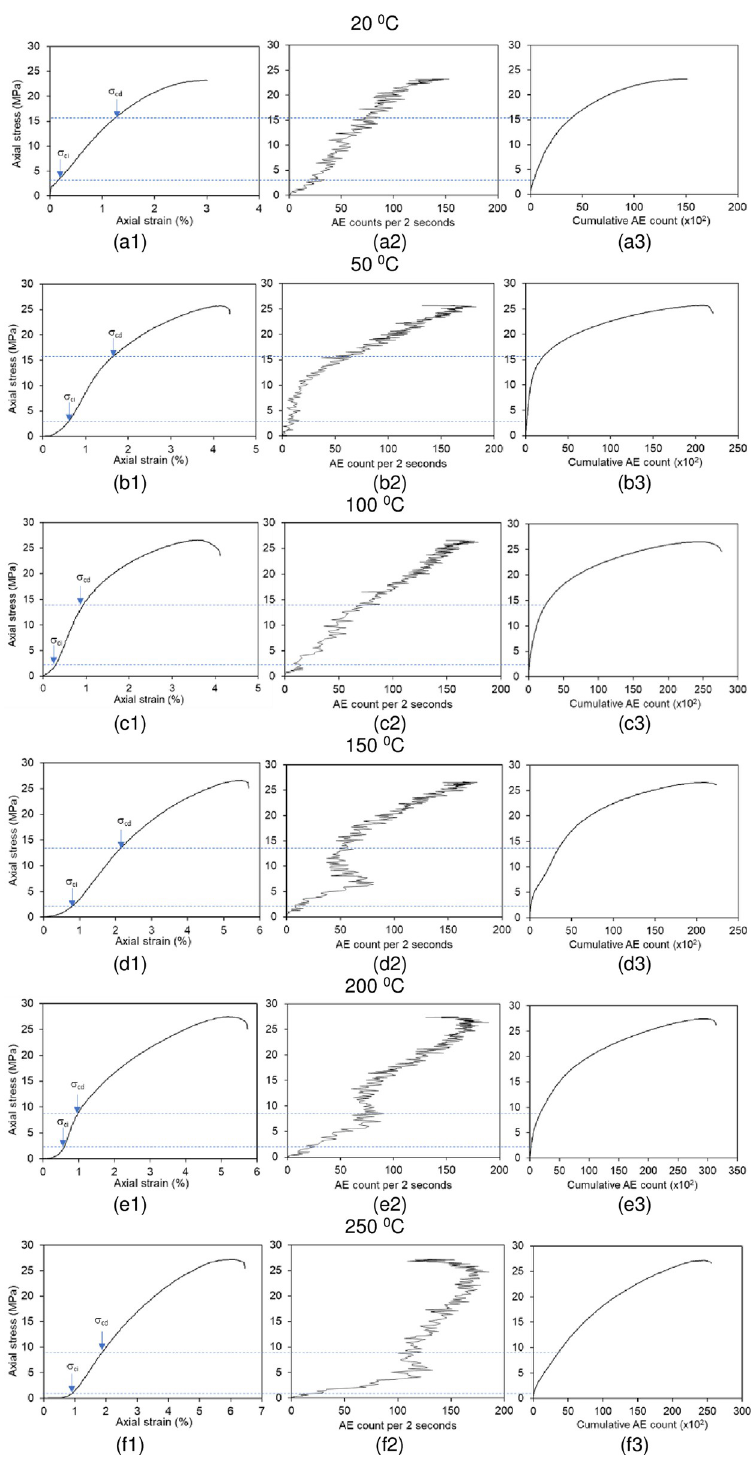
Fig 10. Stress strain curves (from a1 to f1), stress—AE count plots (from a2 to f2) and stress—cumulative AE count plots (from a3 to f3) for the sample temperatures of 20˚C, 50˚C, 100˚C, 150˚C, 200˚C and 250˚C.